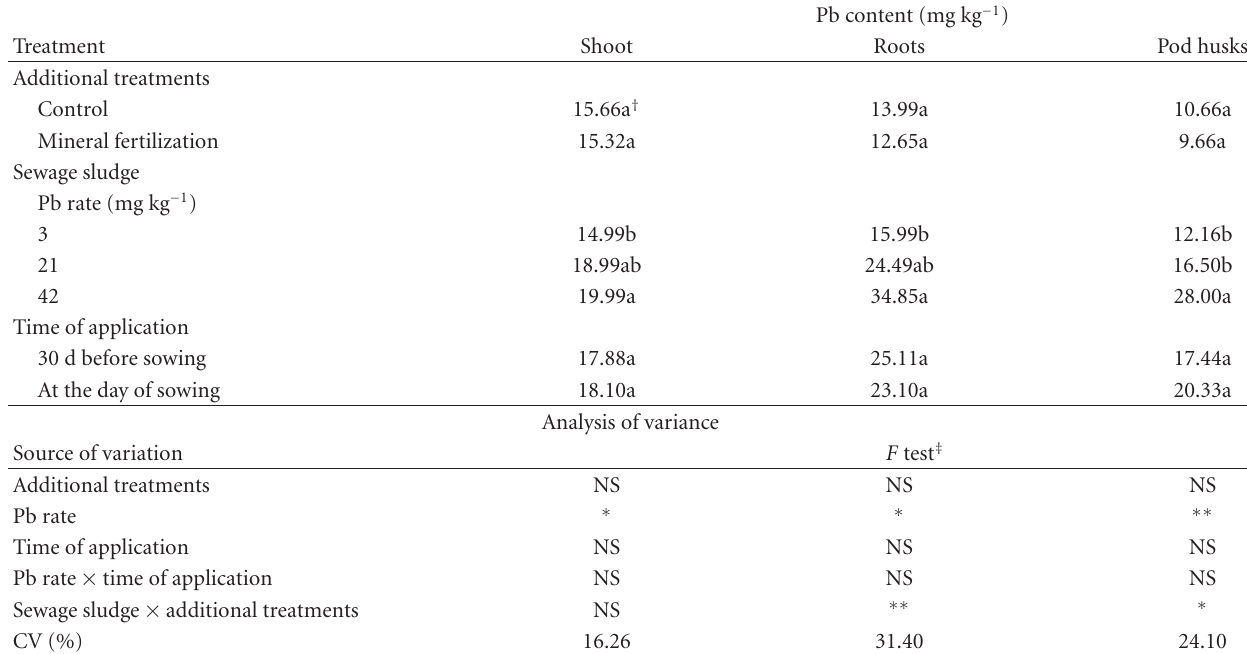
Table 6: Lead content in peanut as a function of Pb rates applied to soil with sewage sludge, time of sewage sludge application, mineral fertilization, and control.